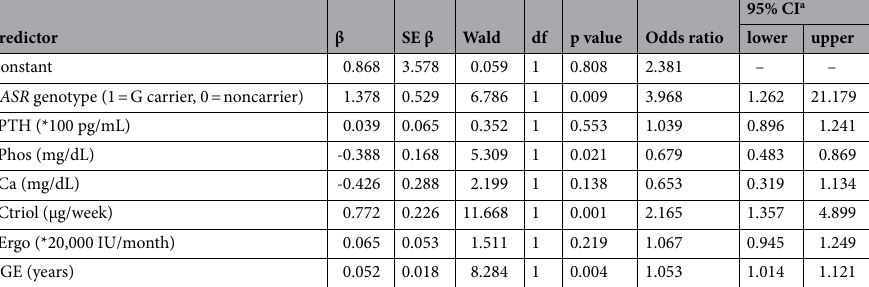
Table 5. Logistic regression analysis results (n = 135). The dependent variable in this analysis is achievement of at least 30% reduction of PTH from baseline value (1 = at least 30% PTH reduction and 0 = less than 30% PTH reduction from baseline); Predicted logit of achieving 30% PTH reduction = 0.868 + 1.378 (if G carrier) + 0.039 (bPTH in *100 pg/mL)—0.388 (bPhos in mg/dL)—0.426 (bCa in mg/dL) + 0.772 (bCtriol in μg/week) + 0.065 (bErgo in *20,000 IU/month) + 0.052 (AGE in years); All tested continuous variables were linearly related to the logit of the dependent variable (Box-Tidwell test, all p > 0.05); Omnibus test of model coefficients, chi- square = 45.940, df = 7, p < 0.001; Nagelkerke R square = 0.388; Hosmer and Lemeshow test, chi-square = 14.753, df = 8, p = 0.064; With the cutoff set at 0.5 for prediction of 30% PTH reduction achievement, the model was able to correctly classify 79.7% of those who achieved at least 30% iPTH reduction and 62.5% of those who did not, for the overall correction prediction of 72.6% β the partial logistic regression coefficient, SE β the standard errors of the partial slope coefficient, df degree of freedom, AGE age on the day of starting cinacalcet, bCa baseline serum calcium concentration, bCtriol baseline calcitriol dose or relative calcitriol equivalent dose of alfacalcidol, bErgo ergocalciferol dose before starting cinacalcet, bPhos baseline serum phosphate concentration, bPTH baseline serum intact parathyroid hormone concentration. a 95% confidence interval of the odds ratio from bootstrapping, based on 5000 bootstrap samples.